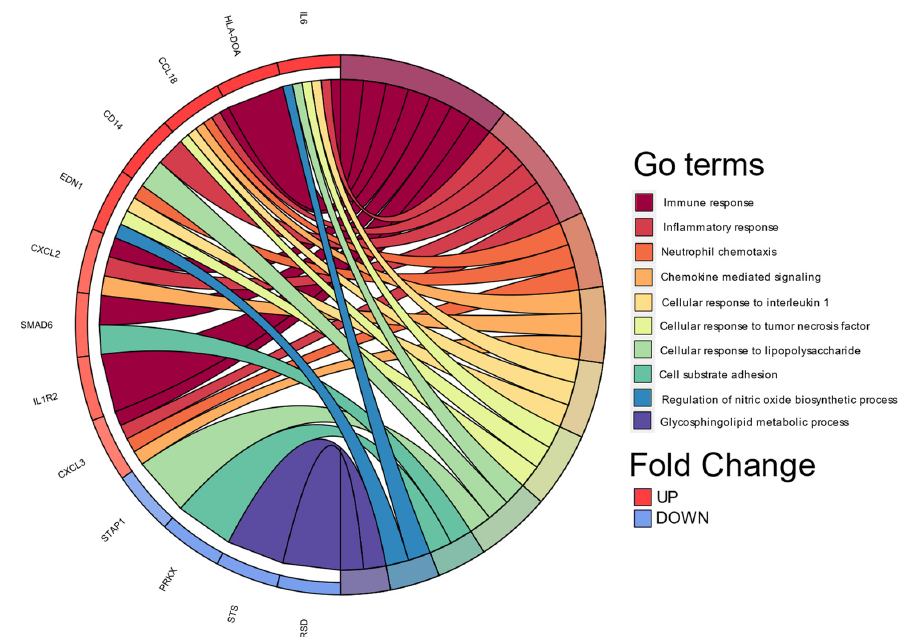
Figure 3. Chord plot of the top 10 Gene Ontology (GO) terms. In each chord diagram, genes contributing to their respective enrichment are shown on the left, and enriched GO clusters are shown on the right. Downregulated mRNAs are displayed in blue, whereas upregulated mRNAs are displayed in red. Each GO term is represented by one colored line. Graph was plotted using Database for Annotation, Visualization, and Integrated Discovery (DAVID) online tool version 6.8.